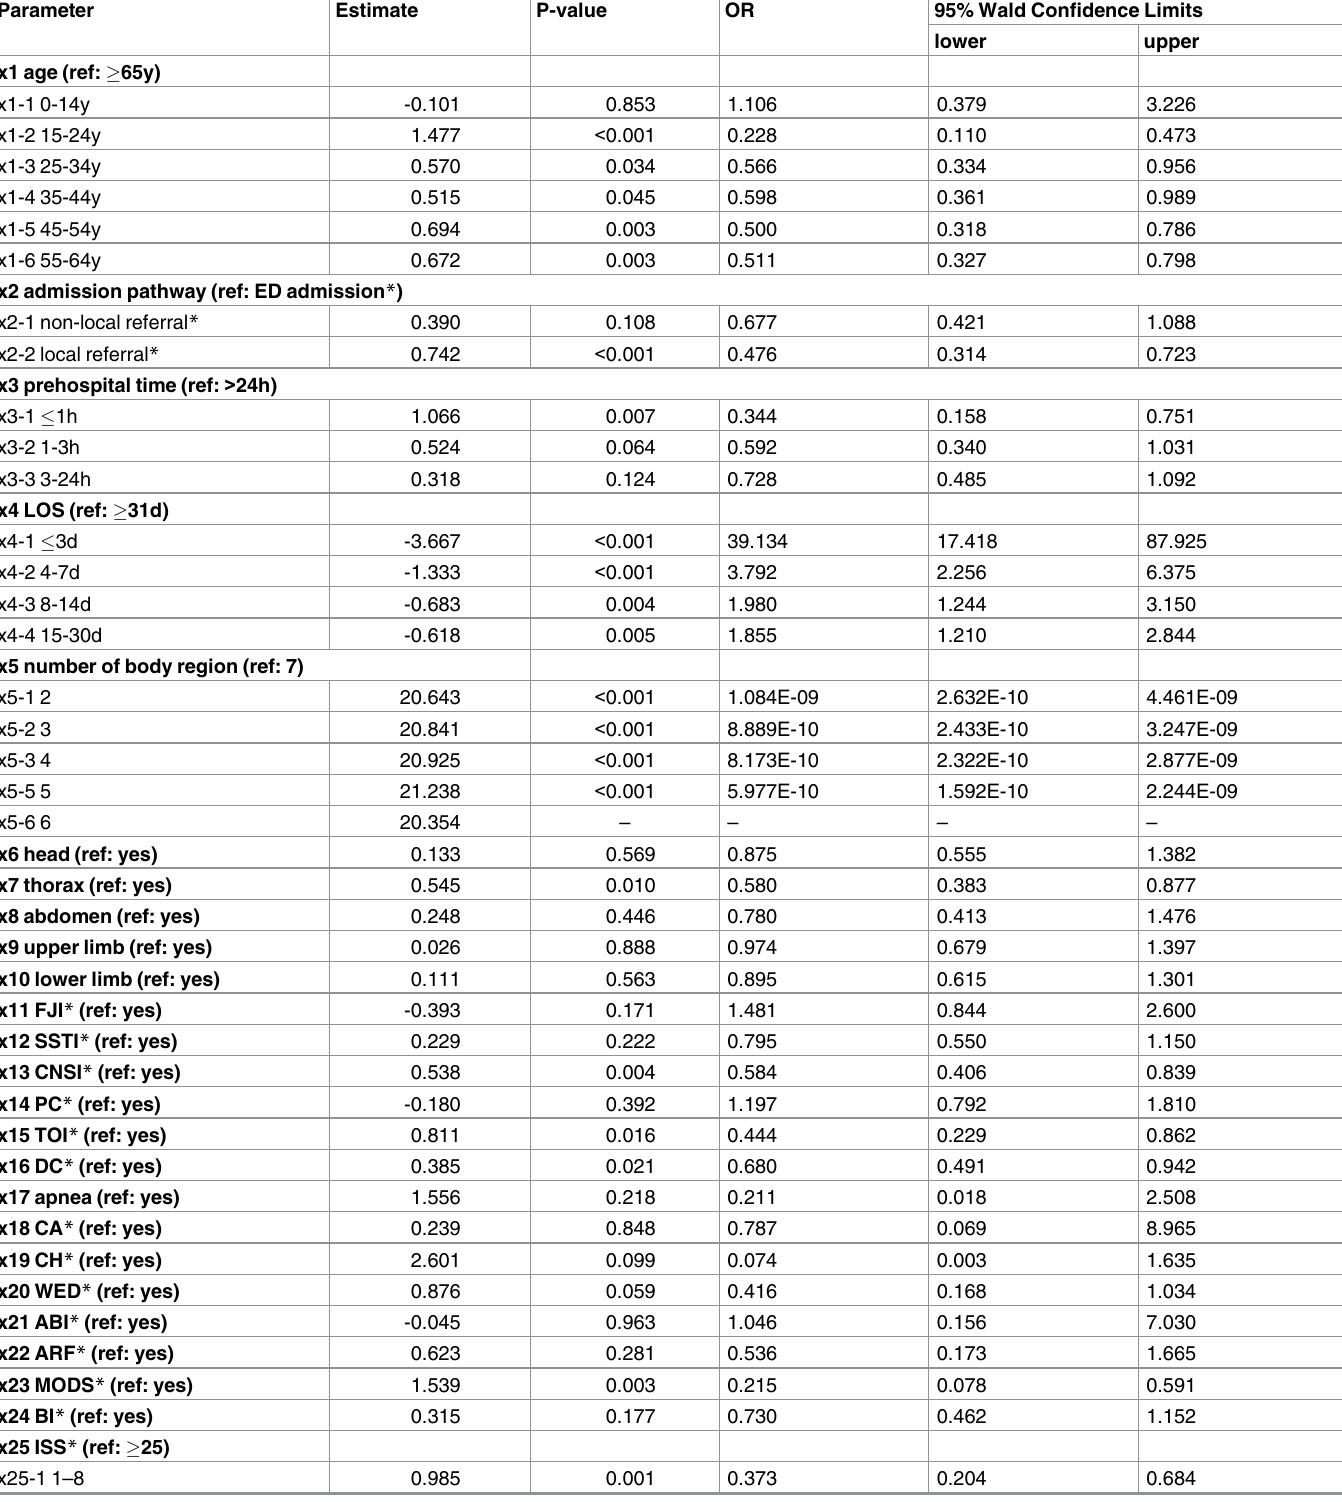
Table 4. Hierarchical logistic regression analysis for multiple-RTI